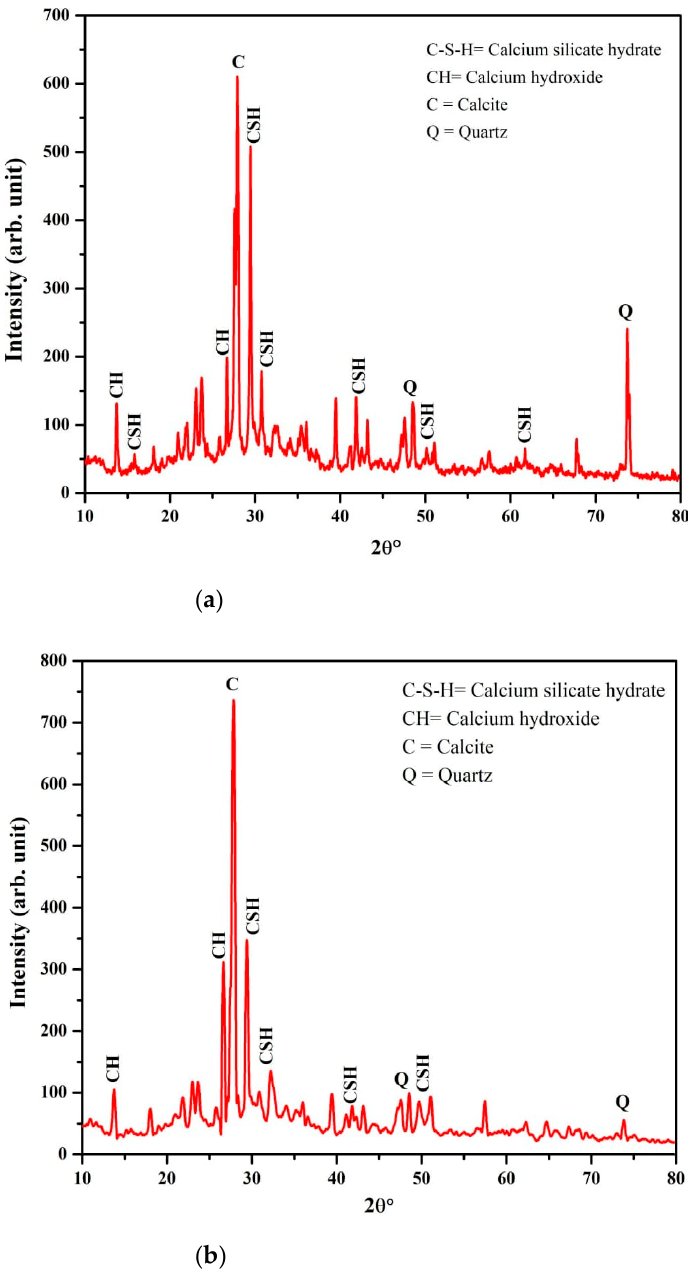
Figure 6. XRD results; ( a ) BA-blended mortar, ( b ) Mortar without BA-blend. SEM images of HT–BA and LT–BA are shown that particles with different sizes and morphology. HT–BA (600 ◦ C/2 h) has porous microstructures (Figure 7a) compared to LT–BA (Figure 7b). It is probably due to the removal of carbon and other components from bagasse ash at a higher temperature (600 ◦ C). We confirmed the effect using DTA–TGA analysis (i.e., at a temperature above 500 ◦ C), and BA mass decreased due to the